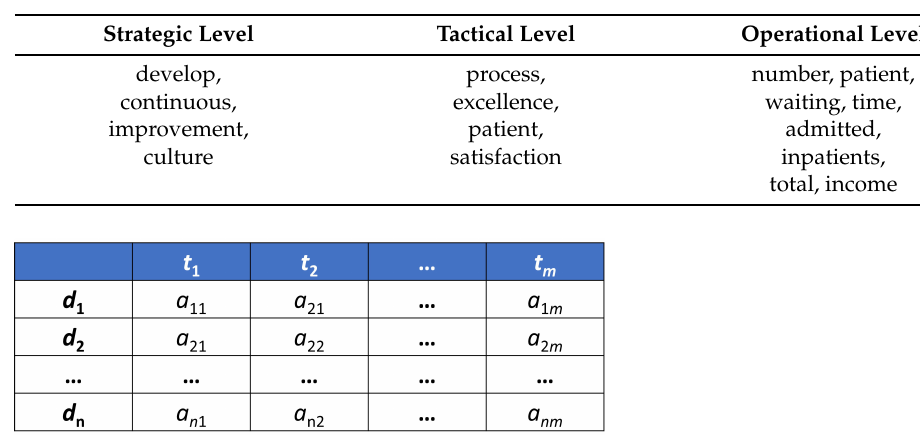
Table 4. Feature pool (some of the special terms in our word bag).